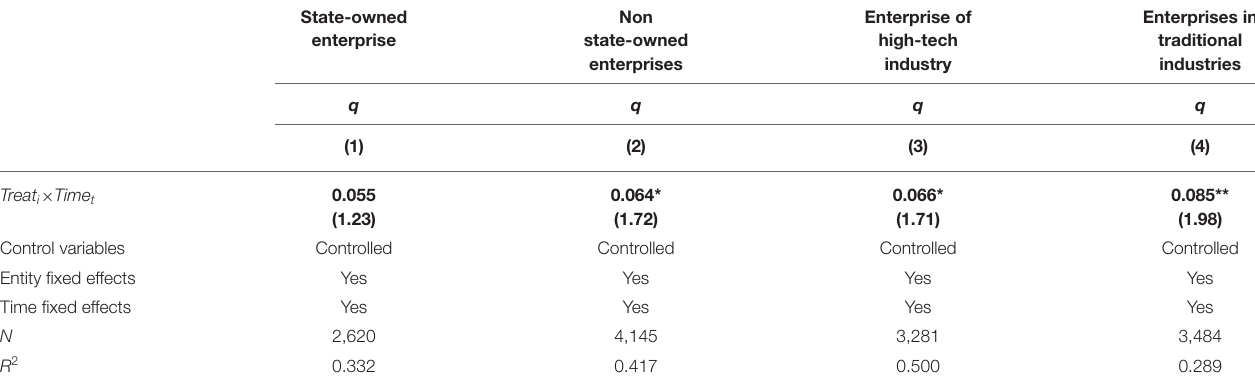
TABLE 7 | Heterogeneity analysis results 1.